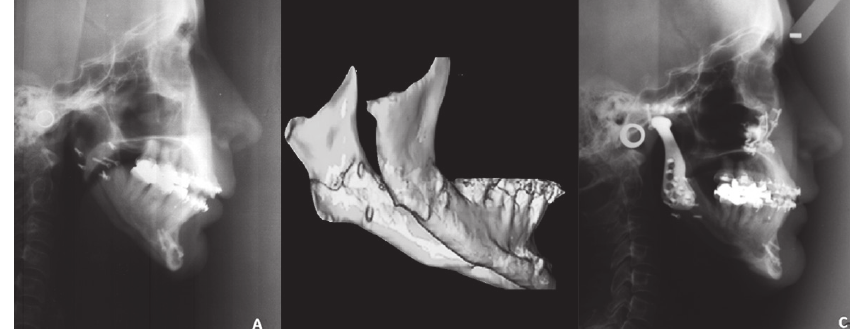
Figure 6- Complete destruction of condyle in a patient who had undergone orthognathic surgery, and was re-treated with the aid of temporomandibular joint prostheses. Before surgery (A), 3D image of the mandible showing bilateral absence of condyles (B), and after surgery